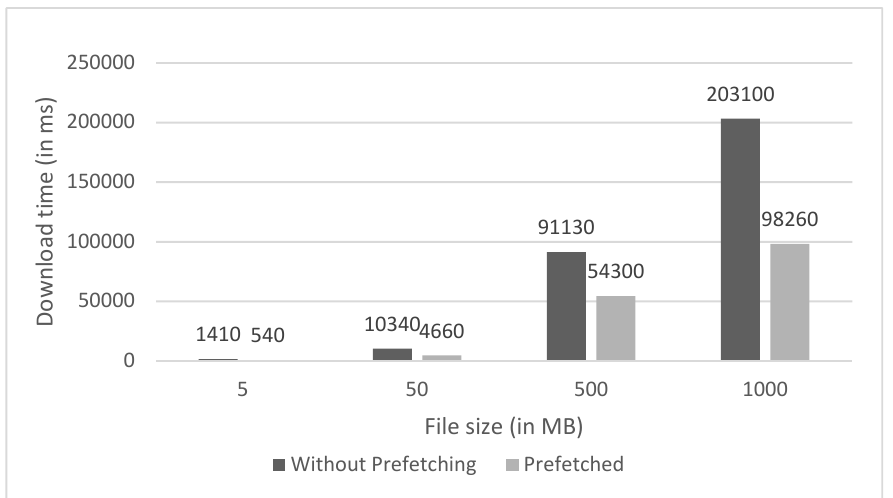
Figure 10. Average download times (in ms) of health record resources with various sizes (5 MB, 50 MB, 500 MB, and 1 GB) when the storage cloud and the prefetch engine were deployed in the same infrastructure but in different nodes (i.e., VMs).